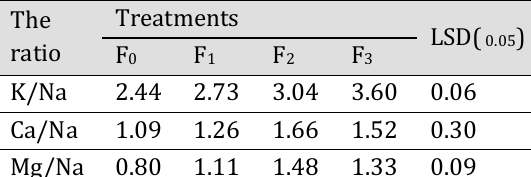
Table 3. Effect of fertilization with potassium and micronutrients on elements ratios in wheat leaves